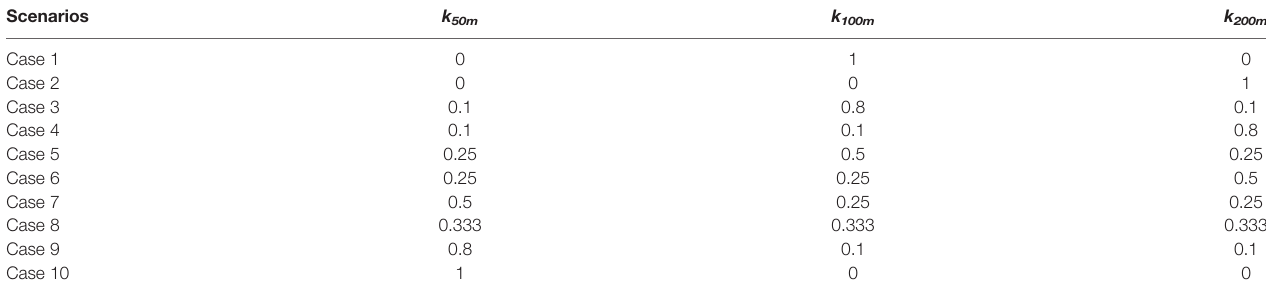
TABLE 1 | Different scenarios for the weights of seawater temperature of different depths.